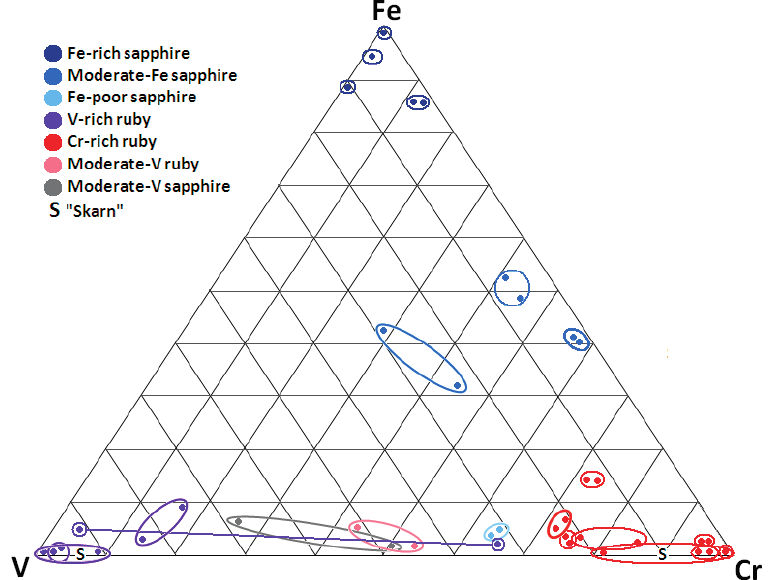
Figure 4. V–Fe–Cr Triangular plots, Mogok corundum. Oval fields encompass core and rim analyses of single crystals. The tied line connects V-rich sapphire core and ruby rim. The symbol S labels Si-Ca-Ga-rich “skarn-like”